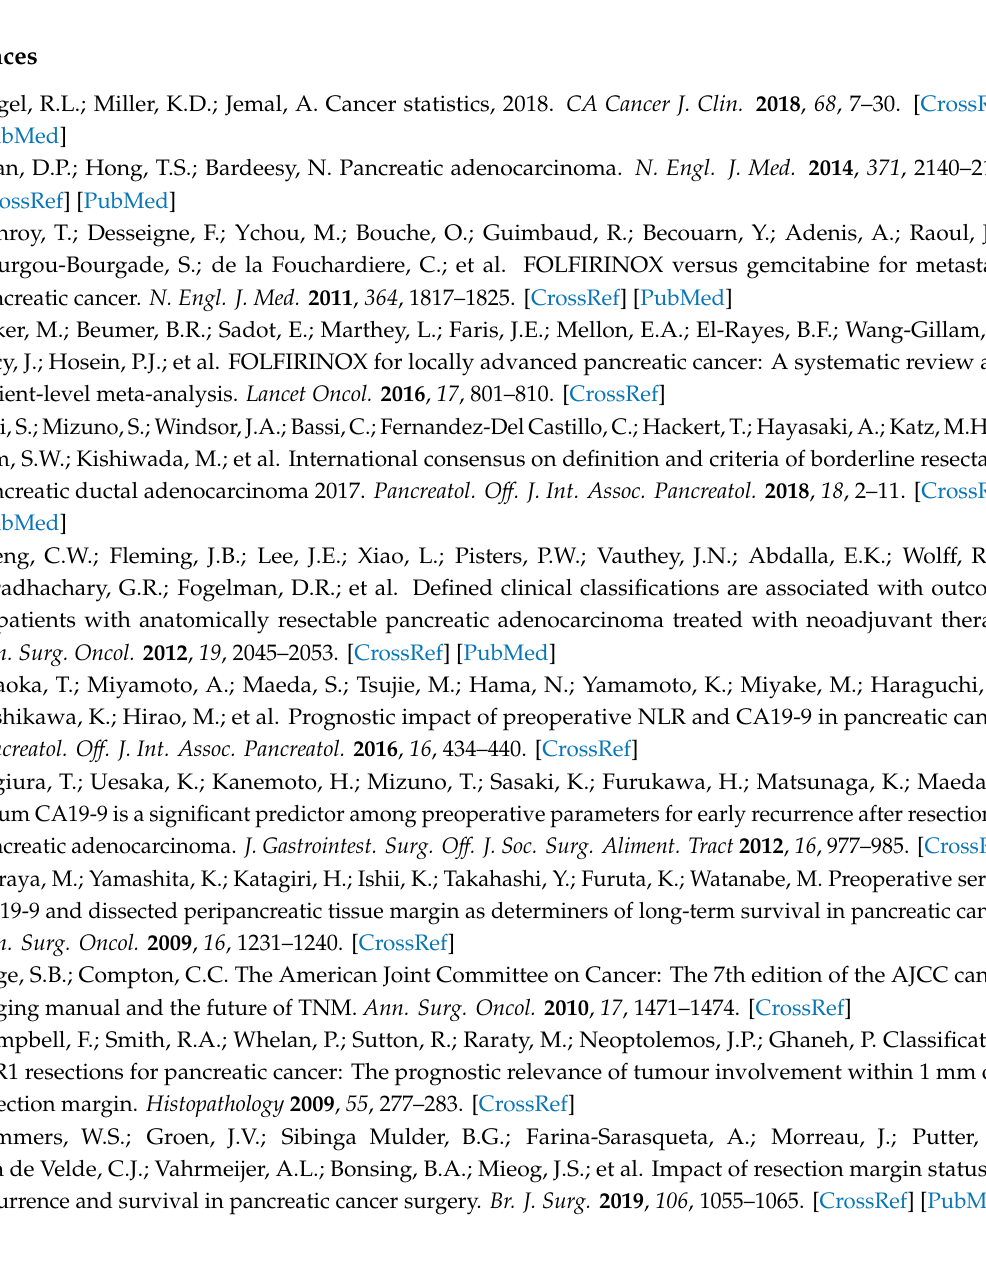
of study selection, Figure S4: Funnel plots of included studies in meta-analysis, Table S1: Multivariable cox regression analysis for overall survival including combined CA19-9 and CEA levels, Table S2: Multivariable cox regression analysis for recurrence in resected PDAC cohort including combined CA19-9 and CEA levels, Table S3: Studies that report on prognostic value of serum CA19-9 and CEA on overall survival in PDAC patients, Table S4: Forest plot of prognostic value of CA19-9 and CEA combined on overall survival in PDAC patients, Table S5. Studies that report on prognostic value of preoperative serum CA19-9 and CEA for early recurrence in resected PDAC